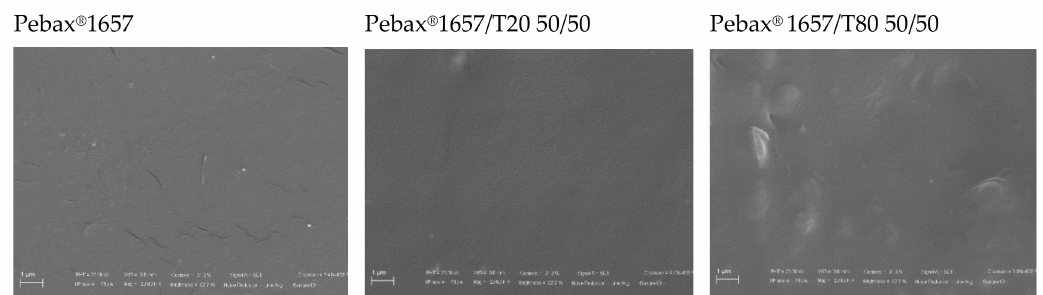
Figure 3. SEM images of the surface of Pebax ® 1657 and Pebax ® 1657 / polysorbate films.